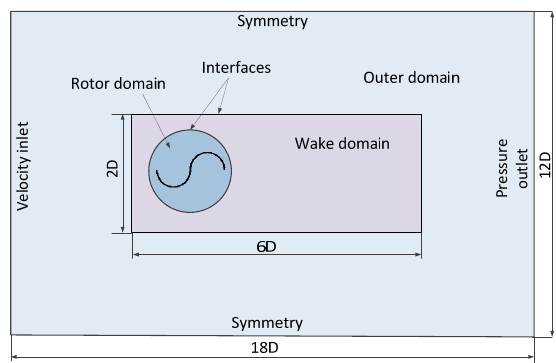
Figure 3. Computing domains and boundary